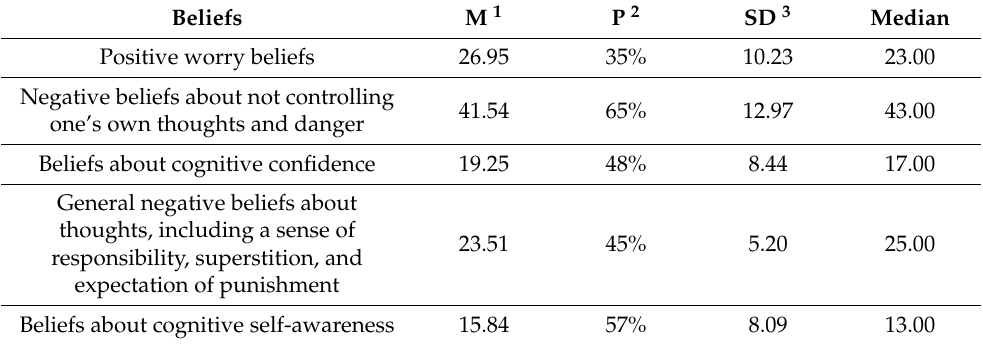
Table 6. Metacognitive beliefs: descriptive statistics for the study